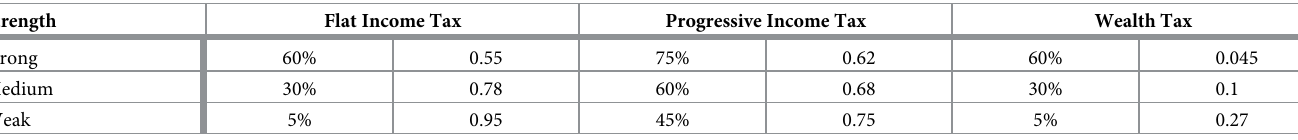
Table notes Gini coefficients for given tax rate (flat income tax, wealth tax) and maximal marginal tax rate (progressive income tax) corresponding to strong, medium and weak tax regimes. Progressive tax starts at 15% (from $150) and ends at given maximal marginal rate at $1550, $1200, $850, respectively.